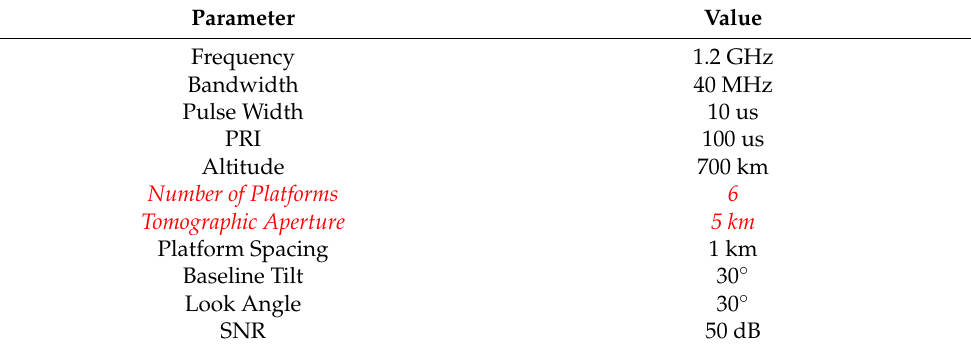
Table 10. Parameters used for Example 7.